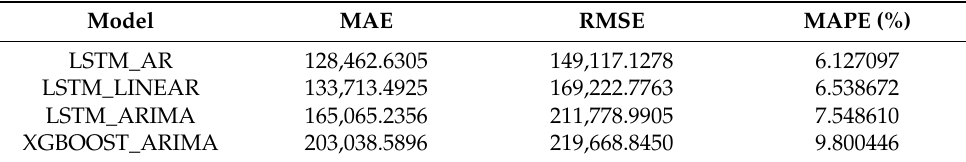
Table 4. Forecasting accuracy of the Marrakech-Safi region for the hybrid